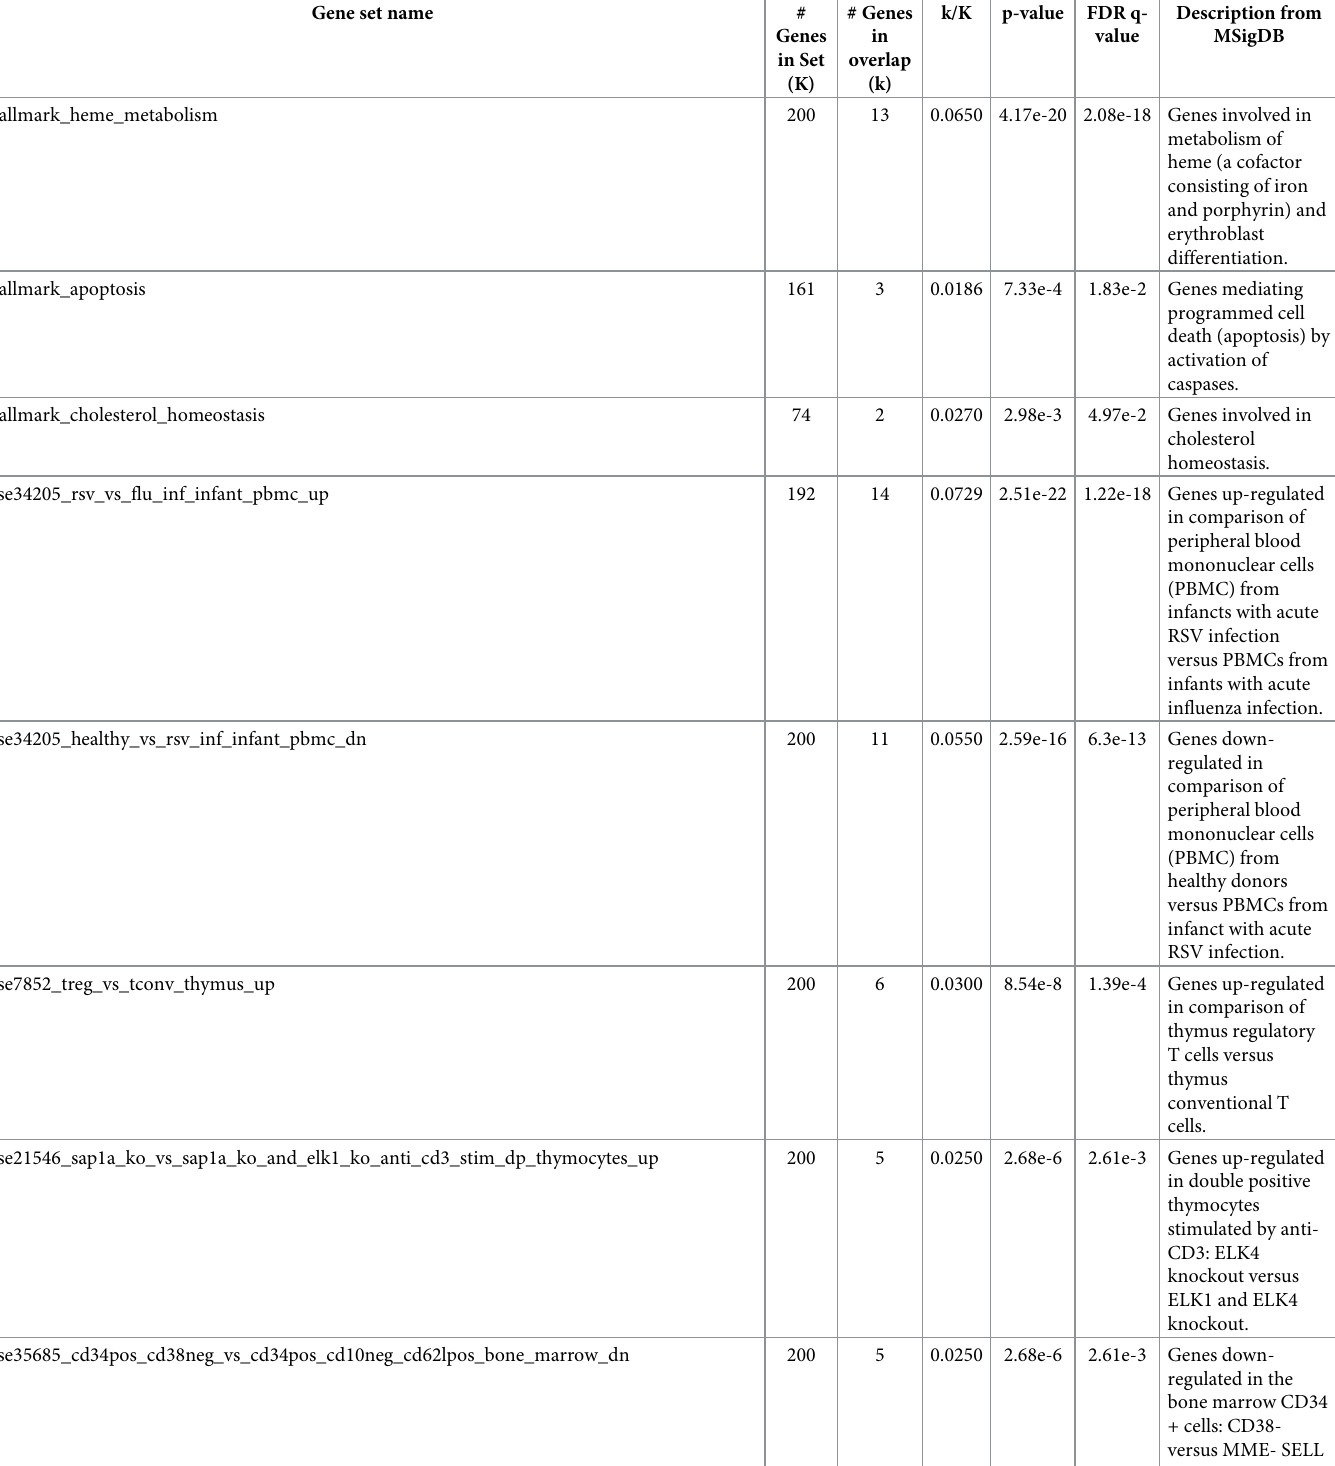
Table 3. Significant gene sets (overlap analysis, FDR < 5%) among the top differentially expressed genes, in blood gene expression profiles from metastatic cases who died during follow-up, compared to